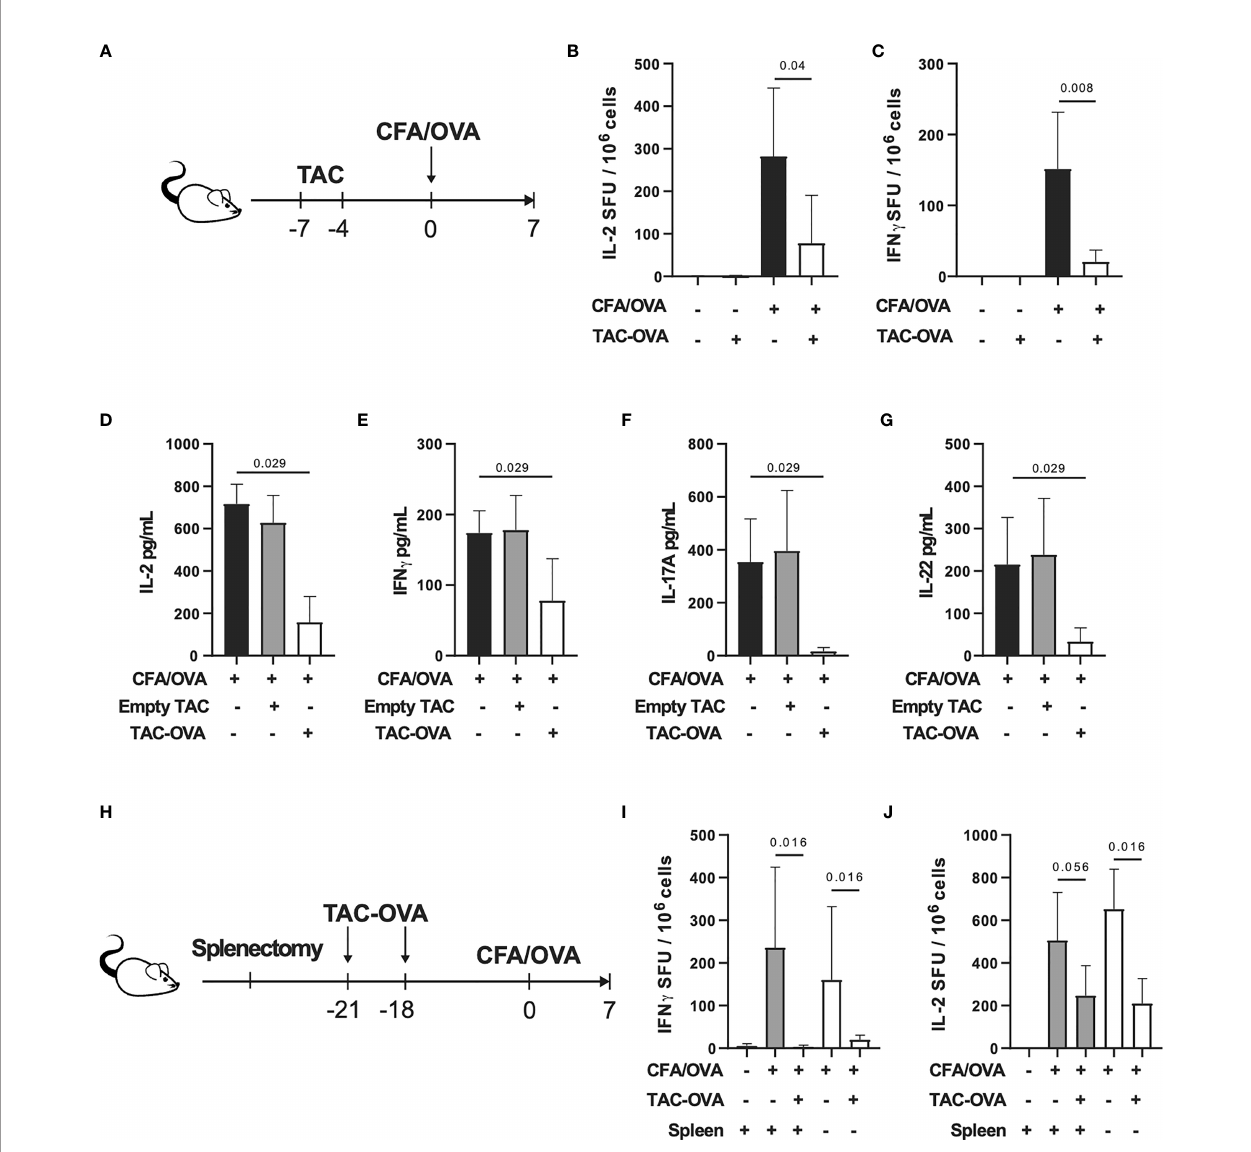
FIGURE 2 | TAC-OVA suppresses endogenous immune responses to OVA challenge irrespective of the spleen. (A-G) C57BL/6 mice were untreated or treated with TAC squeezed with PBS (Empty TAC) or OVA (TAC-OVA) on days -7 and -4. Mice were immunized on day 0 with CFA and OVA. 7 days later, immune responses were assessed in the draining LNs. (B) Number of IL-2 and (C) IFN g producing cells were assayed by ELISpot after restimulation with (B) OVA protein or (C) SIINFEKL peptide. B-C are n = 3 for naïve and n=5 for other groups. Secretion of (D, E) Th1 and (F, G) Th17 associated cytokines after OVA protein restimulation. (D – G) show n=4 pools of 2 mice each per group. (H-J) C57BL/6 mice underwent sham surgery or splenectomy. Mice were either untreated or treated with TAC- OVA and challenged with OVA in CFA. OVA-speci fi c immune responses were assessed in the draining LNs after 7 days by ELISpot. (I) IFN g and (J) IL-2 producing cells after restimulation with (I) SIINFEKL peptide or (J) OVA protein. (I-J) n = 4-5 per group. (A-J) TAC dose was 1x10 9 and OVA squeeze concentration was 100 m M. Mean +/- SD. Mann-Whitney U Test. Representative of at least 2 independent